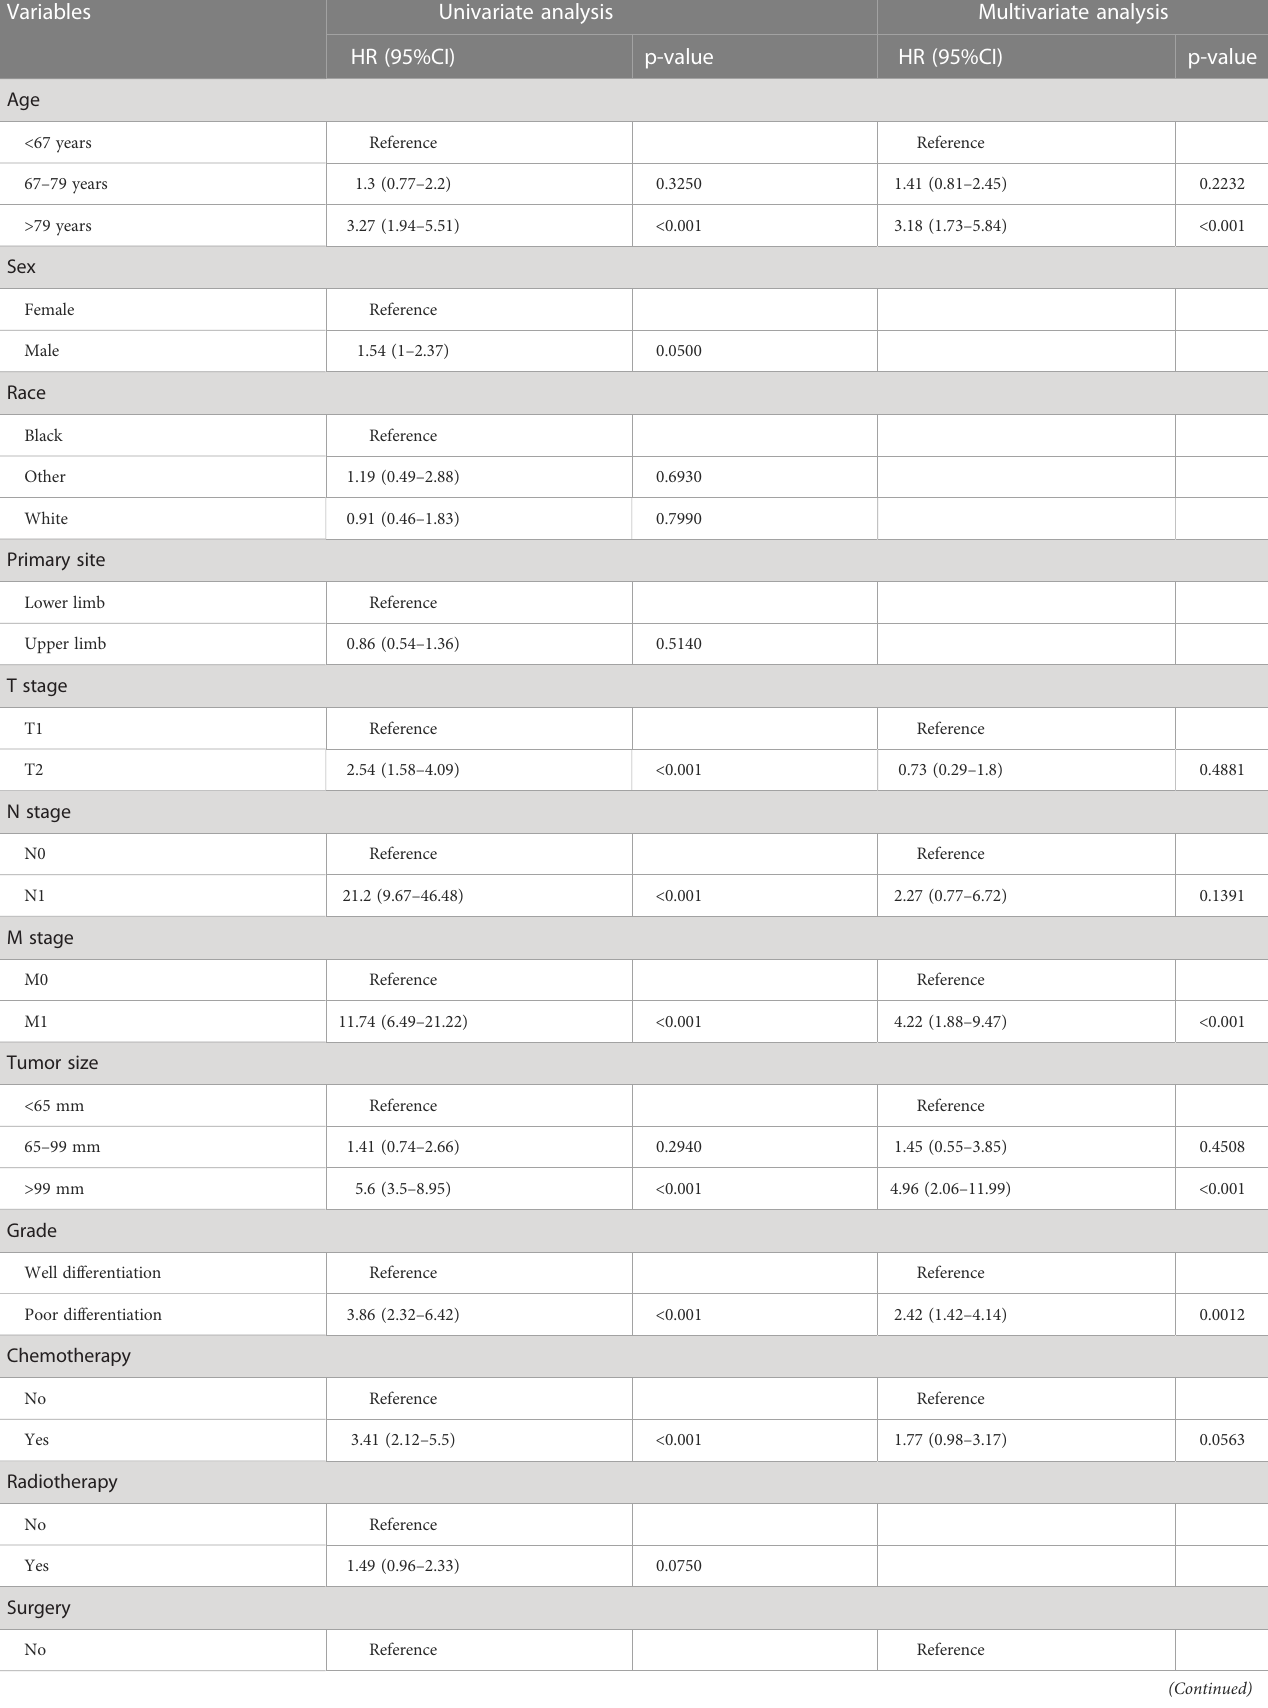
TABLE 3 Univariate and multivariate Cox analyses of cancer-speci fi c survival for patients with